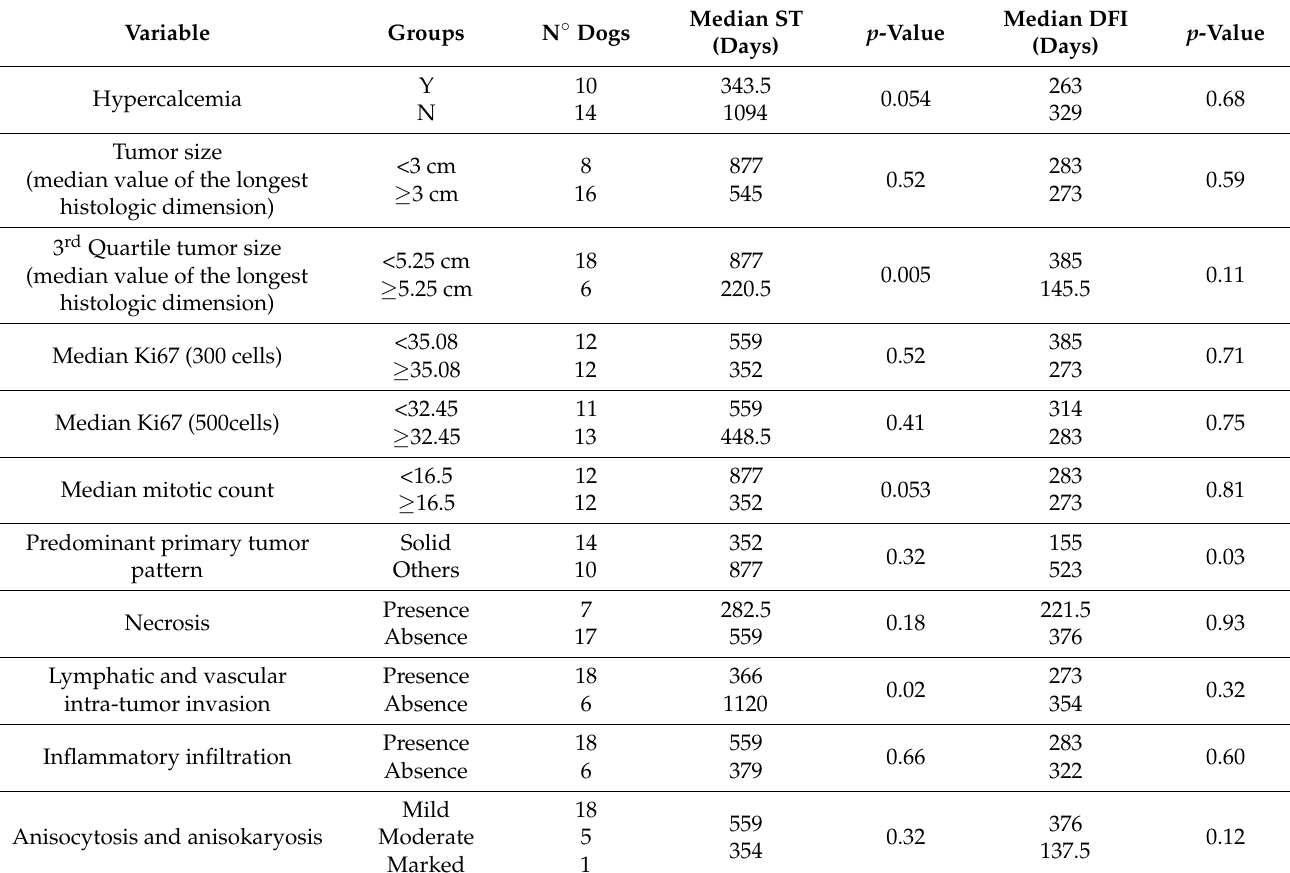
Table 4. Prognostic factors evaluated in dogs with AGASACA and metastatic lymph